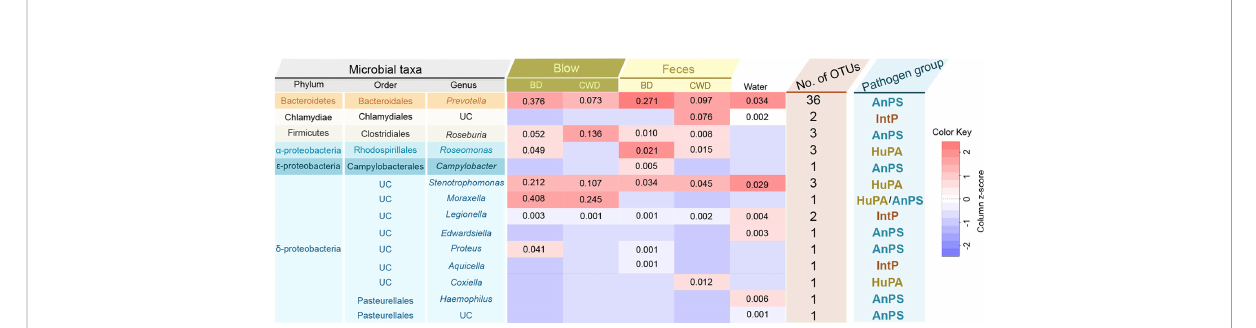
FIGURE 8 Taxonomic and functional information of potential pathogenic taxa. ‘ Microbial taxa ’ indicates the classi fi cation details of each potential pathogenic taxa. UC denotes ‘ unclassi fi ed ’ . The heatmap in the middle indicates the log-transformed and column-scaled abundance data of potential pathogenic taxa present in fi ve different sampling groups. BD, bottlenose dolphins; CWD, the Chinese white dolphin. Decimals indicate the relative abundance (%) of each pathogenic taxa, and the empty value indicates zero. ‘ No. of OTUs ’ indicates the number of OTUs detected from each potential pathogenic taxon. ‘ Pathogen group ’ indicates potentially pathogenic group of the pathogenic taxa predicted based on the FAPROTAX database. AnPS, animal parasites or symbionts; IntP, intracellular parasites; HuPA, human pathogens all.